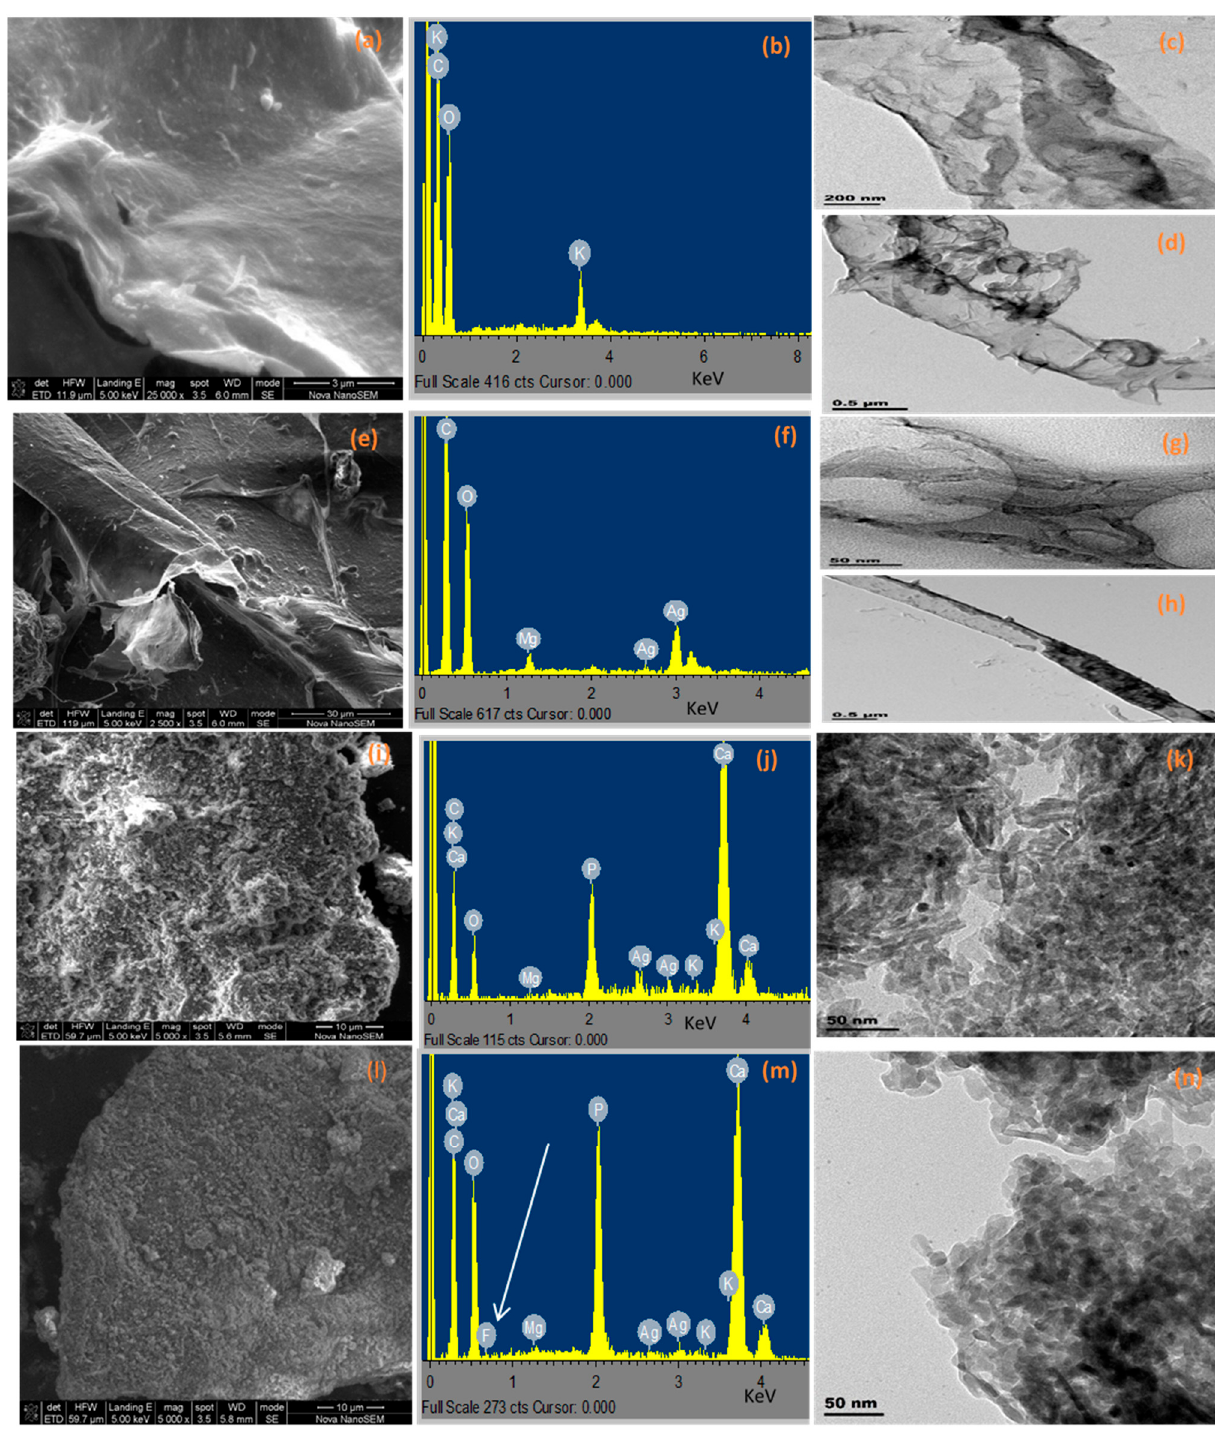
Figure 2. SEM, EDS and TEM of ( a – d ) CNF derived from sawdust waste; ( e – h ) CNF-AgMgO composite, ( i – k ) CNF-AgMgOnHaP adsorbent before fluoride sorption; ( l – n ) CNF-AgMgOnHaP adsorbent after fluoride